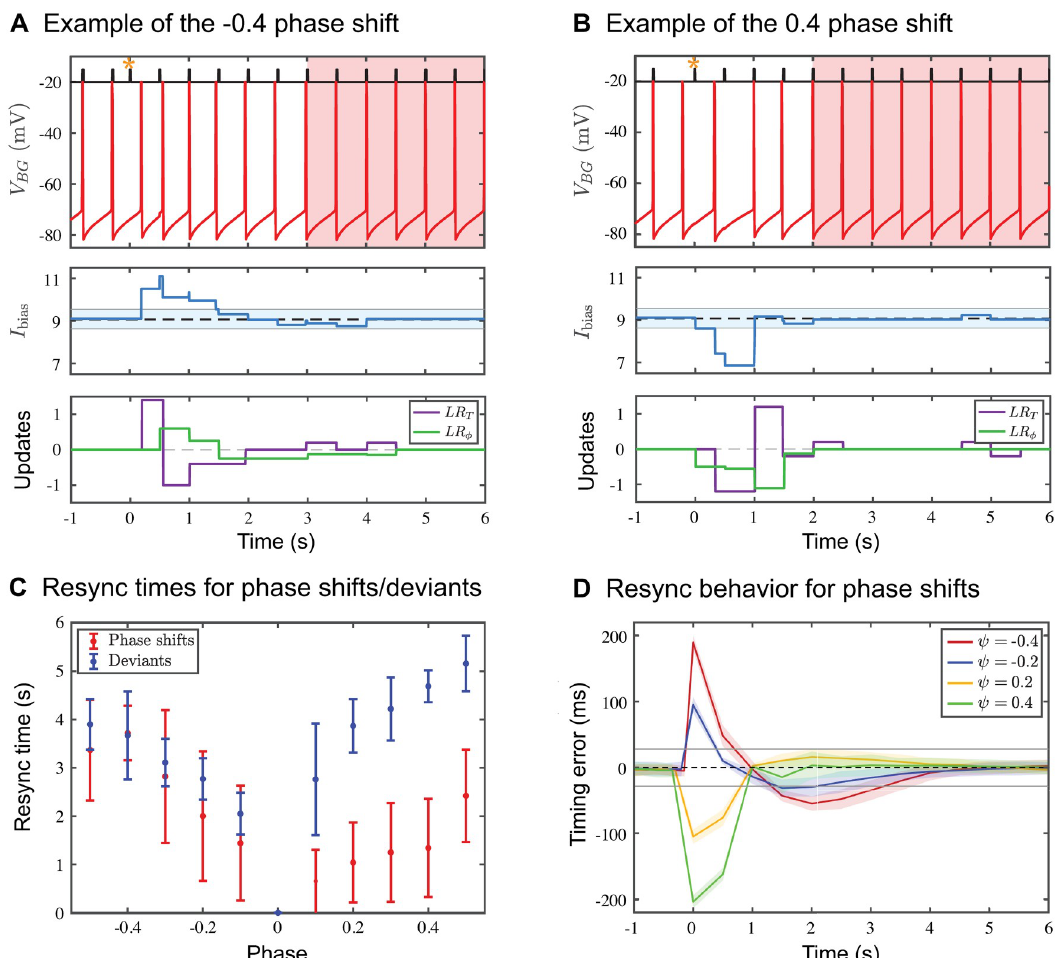
Fig 8. Response to phase shifts and deviants. The description of generic features of each panel is the same as in Fig 7. A . and B . Two specific examples show that resynchronization to a positive phase shift is faster than to a negative one. Negative phase shifts cause a transient increase to I bias as shown in the middle panel; positive phase shifts have the opposite effect. After the transient, the return to baseline is faster for the positive phase shift because the BG interprets this as equivalent to resynchronization to a higher frequency. C . Mean resynchronization times and standard deviations for baseline 2 Hz oscillations are shown for phase shifts (red) and deviants (blue). Notice the asymmetry for both situations, and that resynchronization to a phase shift is generally faster than to a deviant. D . Characteristic time courses of average timing differences (standard deviation shaded) for phase shifts give further evidence for the asymmetry in resynchronization times. Note that for the negative phase shifts the model produces an overshoot, where the timing errors temporally fall outside the region of one gamma cycle accuracy (gray line) before returning to it later for eventual